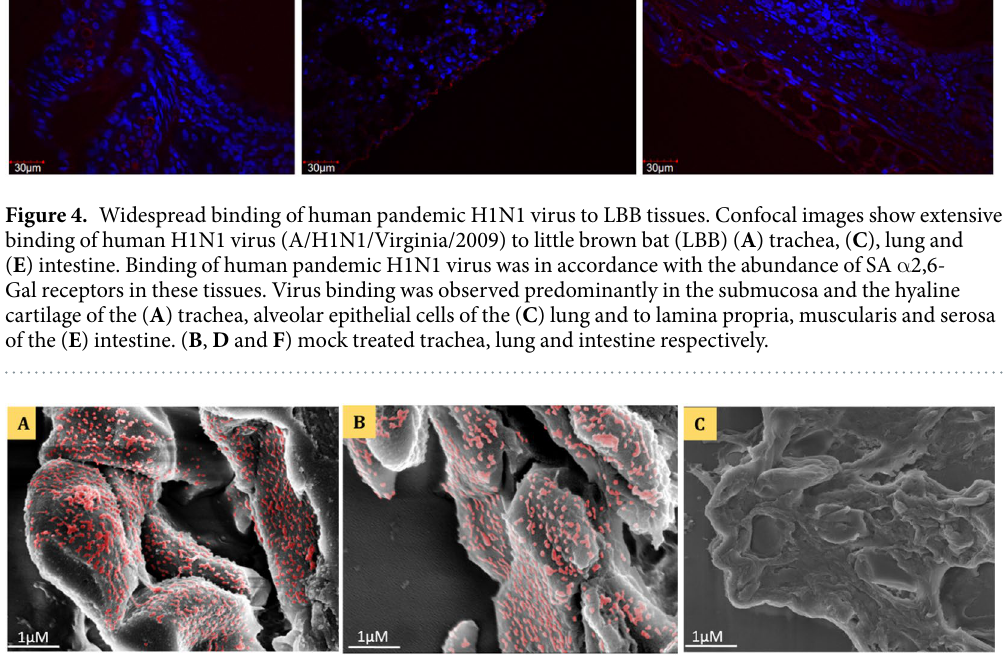
5 Scientific RepoRts | 7: 660 | DOI:10.1038/s41598-017-00793-6